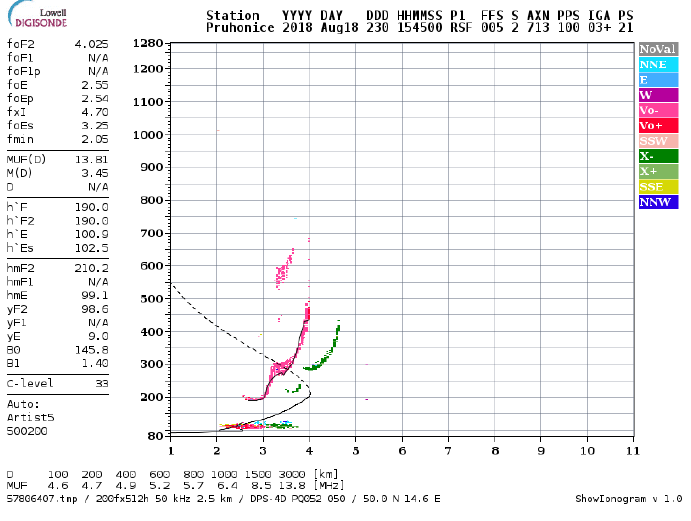
Figure 5. Pruhonice ionosonde plot 18 August 2018, 15:45 UTC. F-layer reflection (curved traces) can be seen above 200 km virtual height. E-layer reflection (horizontal trace) can be seen at just over 100 km virtual